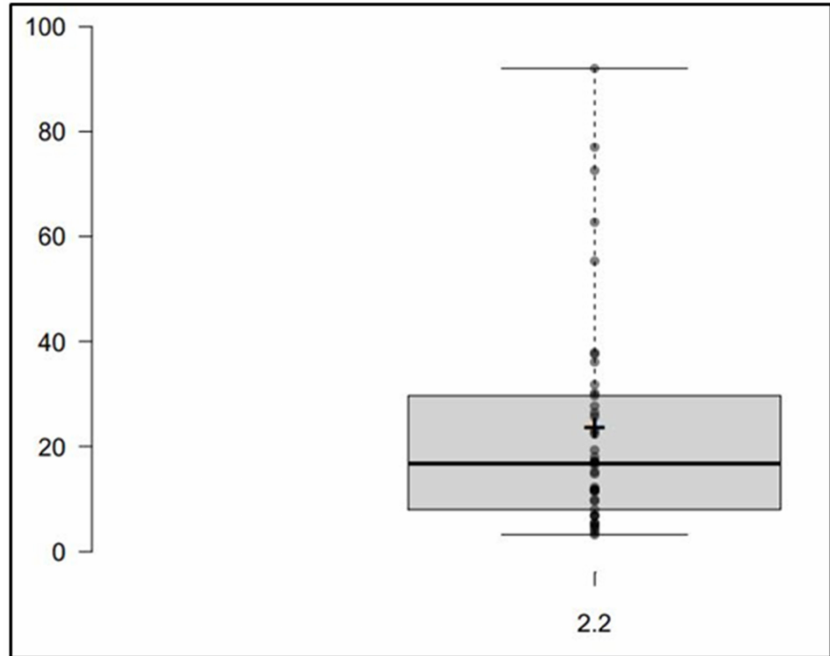
Figure 5. Box plot performed with the free online BoxPlotR tool, showing the spread of the MRP concentration measured in 42 real patients’ plasma microsamples. Population size: 42; Median: 16.75; Mean: 22.89; Minimum: 2.2; Maximum: 92.0; First quartile: 8.0; Third quartile: 29.7.